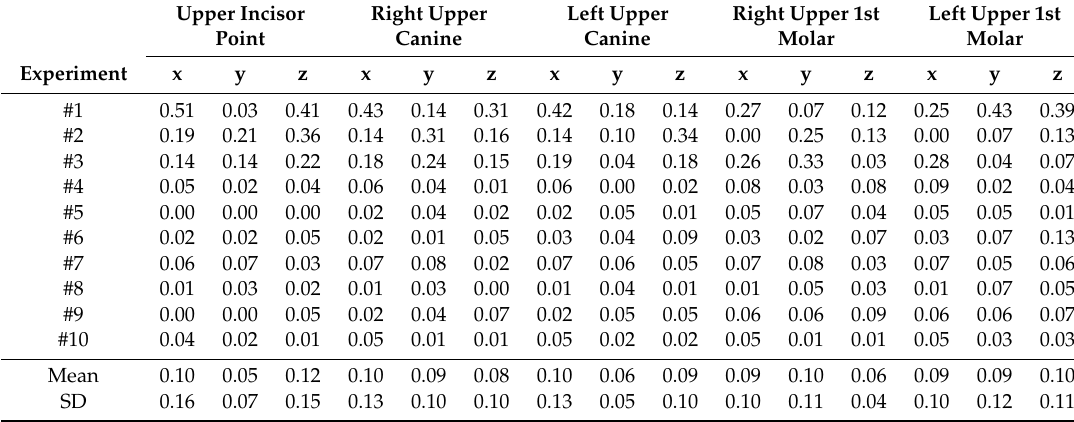
Table 2. Absolute Deviation between the Planned and Achieved Positions for Five Dental Landmarks.